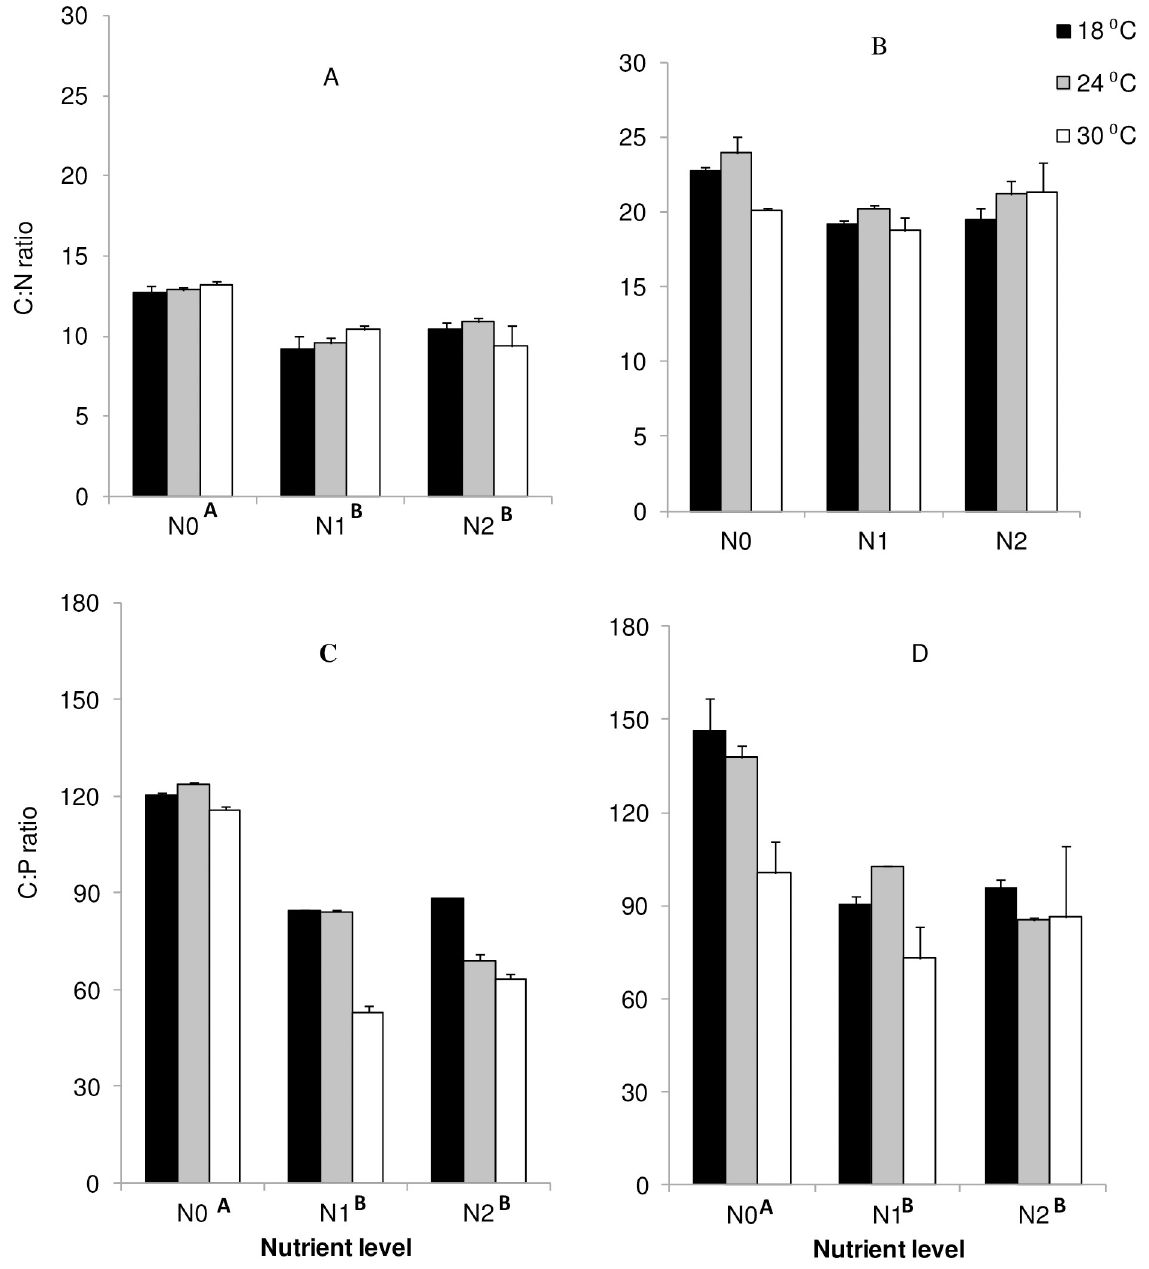
Fig 5. Main and interactive effects of temperature and nutrient treatments on Carbon: Nitrogen (A & B) and Carbon: Phosphorus (C & D) ratio for Z . capensis . A & C = aboveground values, C & D = belowground values. Values mean ± SE. Different capital letters adjacent to nutrient levels denote differences among nutrient